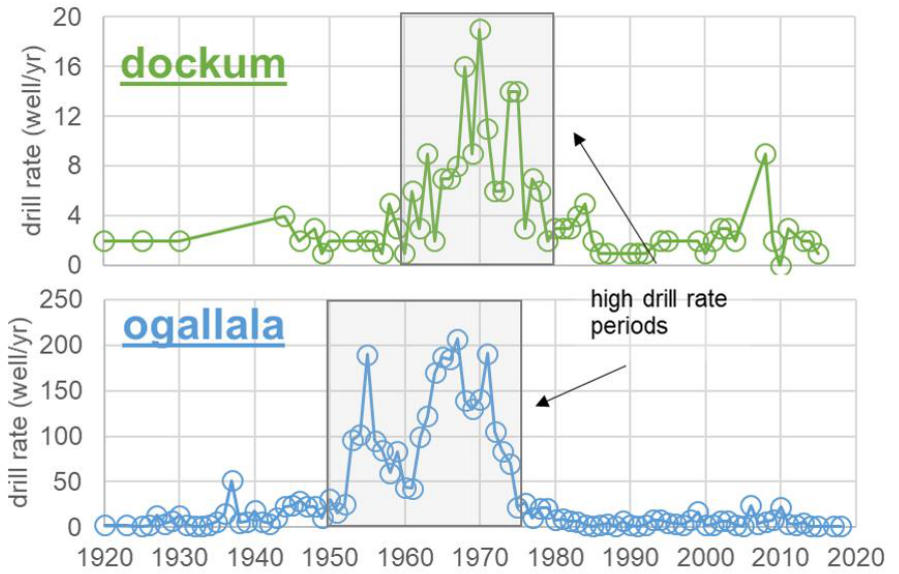
Figure 4. Historical annual well drilling rates for the Dockum and Ogallala Aquifers. Well records without the drilling date have been excluded. Thus, excluded were 129 wells for Dockum (34% of all single aquifer unit wells) and 2054 wells for Ogallala (38% of all single aquifer unit wells).